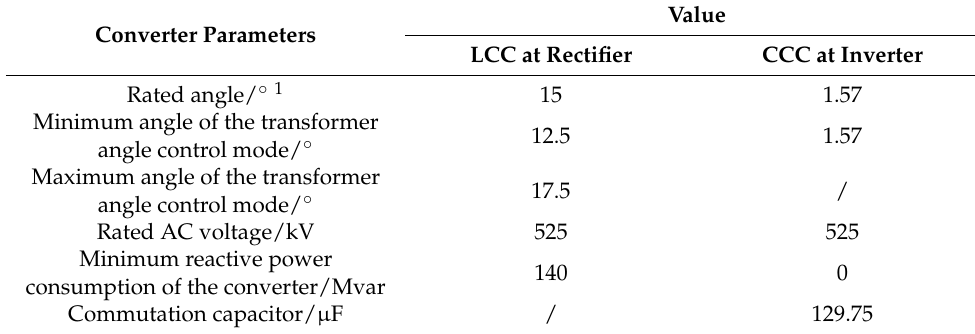
Table 4. Converter parameters of the LCC-CCC HVDC transmission system.